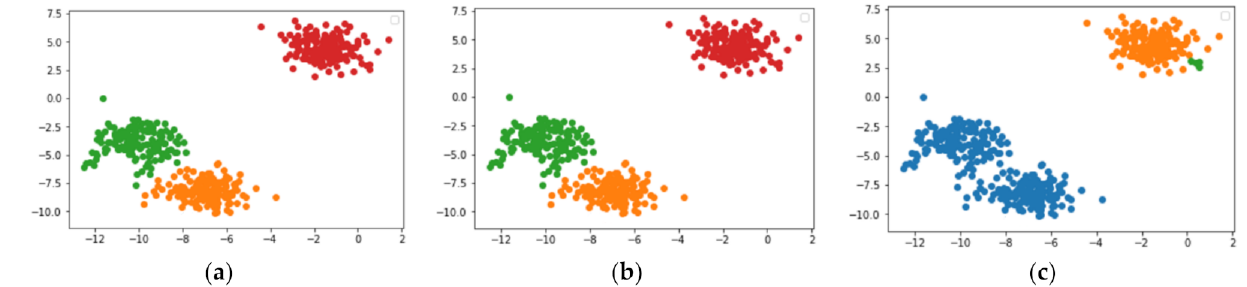
Figure 8. Visual result of proposed method with CS = 0.7 and ( a ) DM = 2, ( b ) DM = 3, and ( c ) DM =